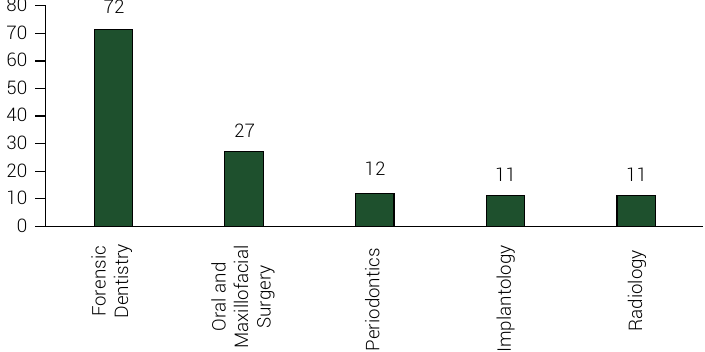
Regarding the 161 lawsuits that appointed an expert witness, 68% (n=110) of these included indications of technical assistants, with 9% (n=10) of the indications made only by the requesting part, 63% (n=69) only by the requested part, and 28% (n=31) by both parties. Regarding question formulations, they were present in 84% (n=136), with 7% (n=10) being performed only by the requesting part, 21% (n=29) only by the requested part and 71% (n=97) by both